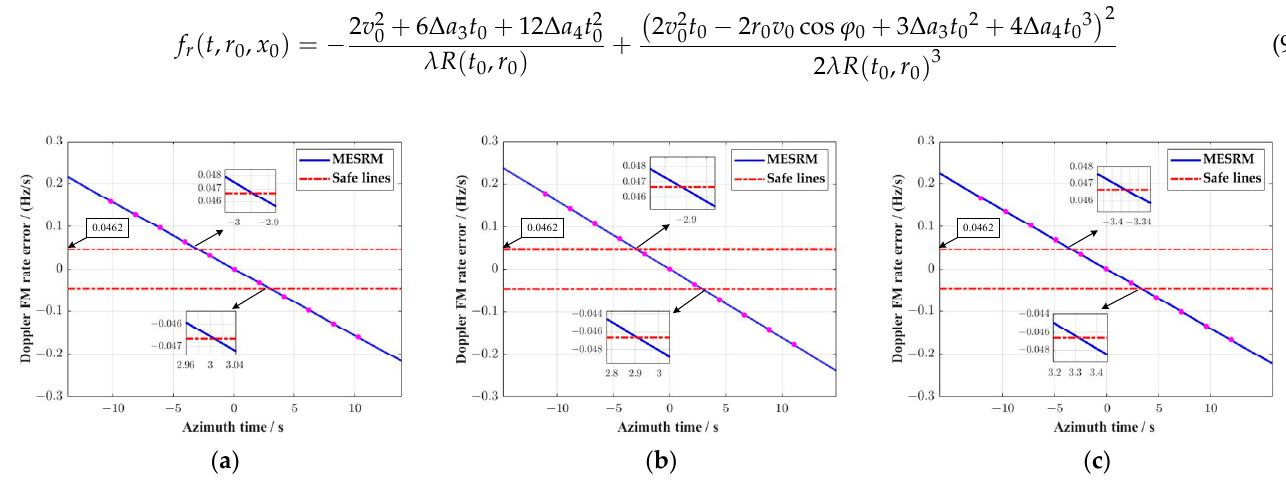
Figure 4. The DFMR error as a function of azimuth time caused by MESRM. ( a – c ) represent the DFMR errors at near, central, and far range cells, respectively.